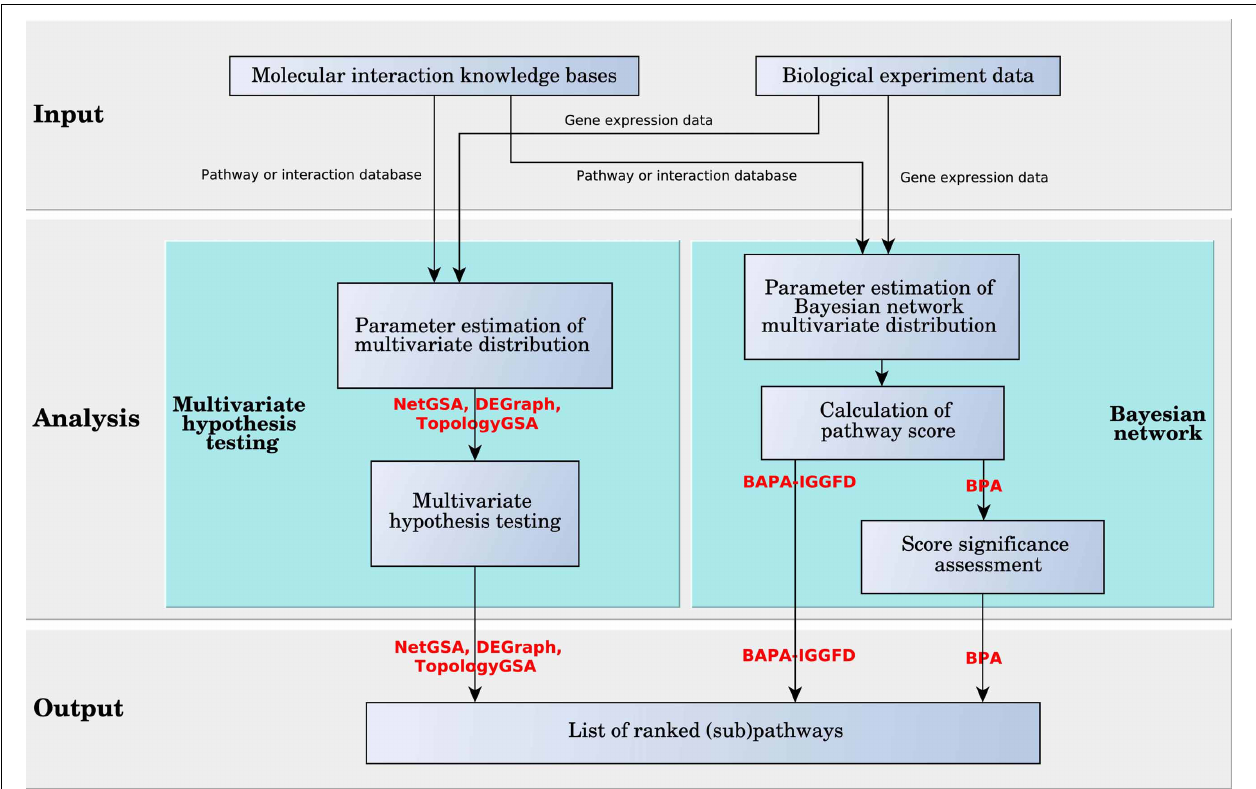
FIGURE 8 | Diagram of pathway analysis scoring approaches for multivariate scoring